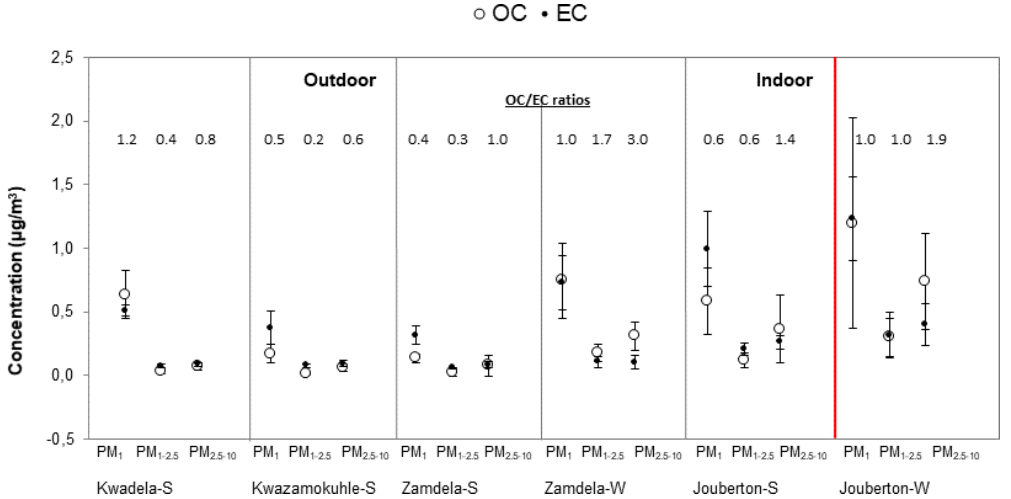
Figure 8. Mean OC and EC concentrations ( ± SD) measured in PM 1 , PM 1 − 2 . 5 , and PM 2 . 5 − 10 at each site during respective sampling campaigns, together with mean OC / EC